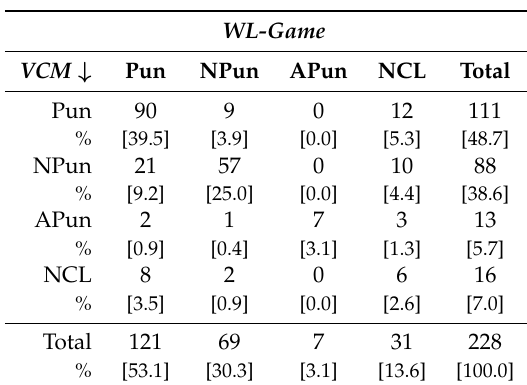
Table 2. Individual punishment type